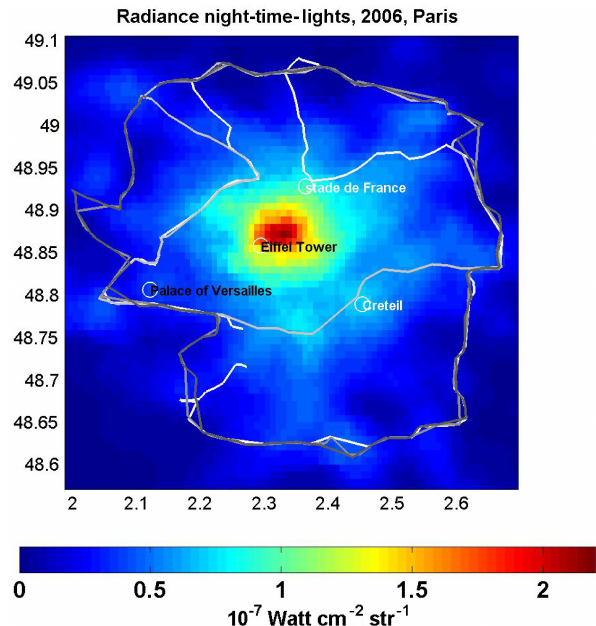
Figure 9. Spatial distribution of the nighttime lights for the selected area around Paris. Different driving routes for 2 days in summer and 2 days in winter are